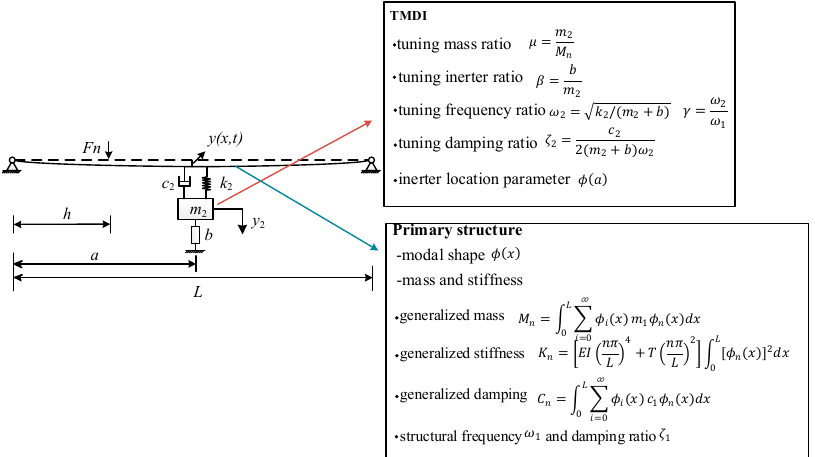
Figure 6. Transmission line—TMDI system model.